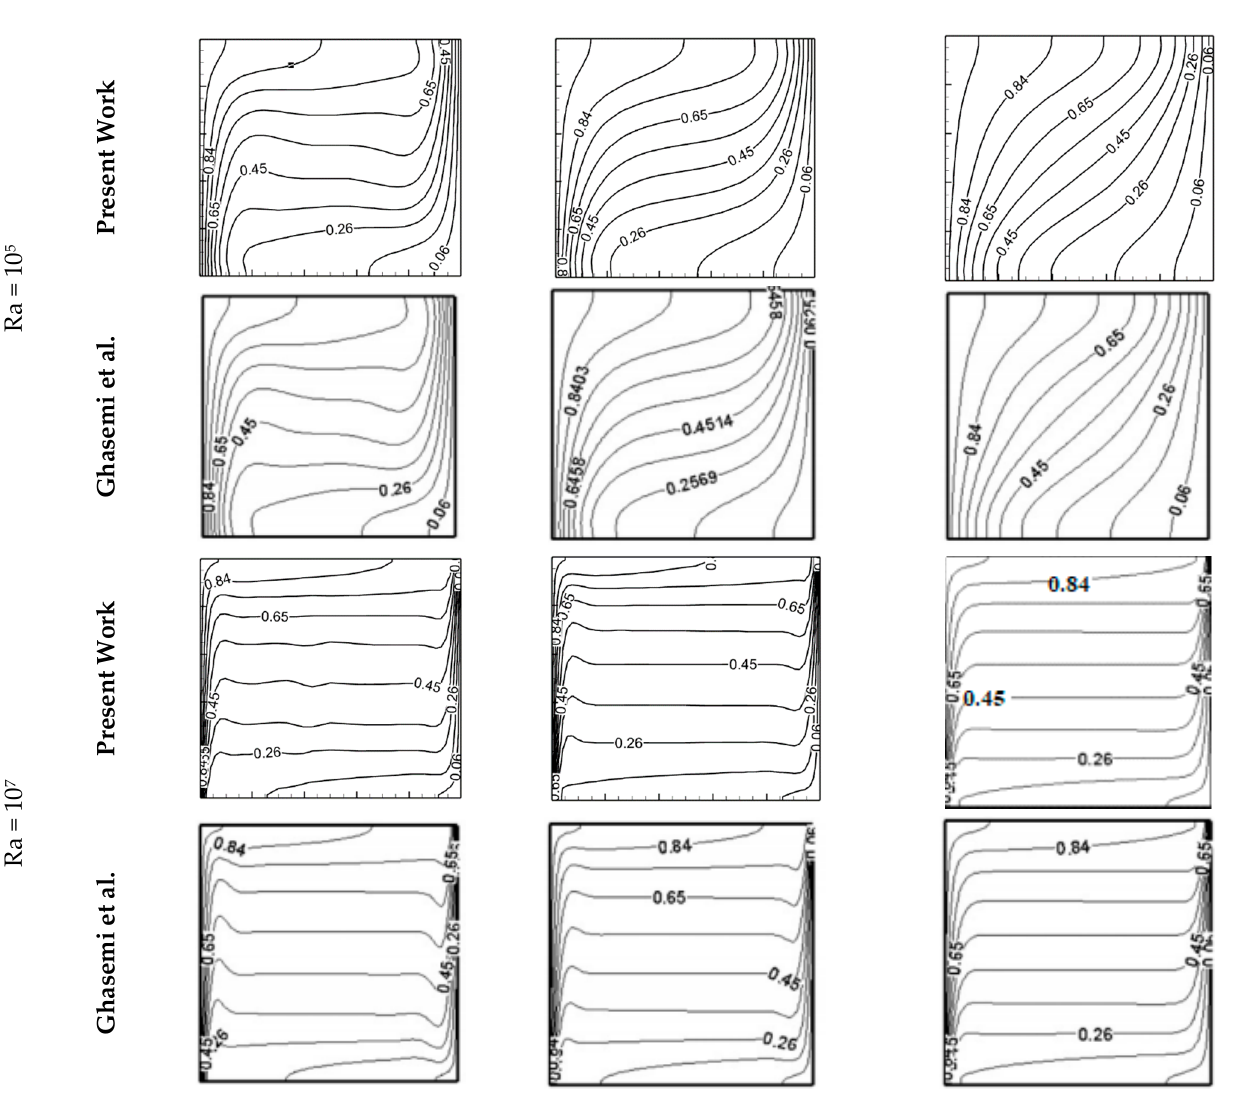
Figure 3. Comparison of isotherms between the present work and Ghasemi et al. [54] for various values of Hartmann and Rayleigh numbers at ( φ = 0.03).